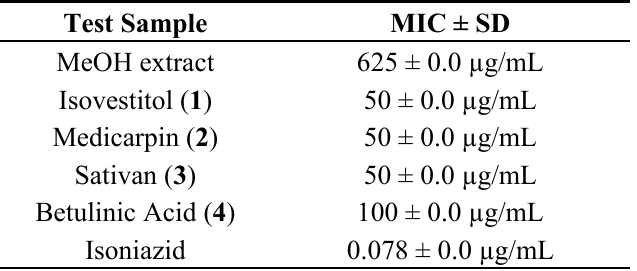
Table 2. Antituberculosis activity of extract and compounds 1 – 4 against M. tuberculosis